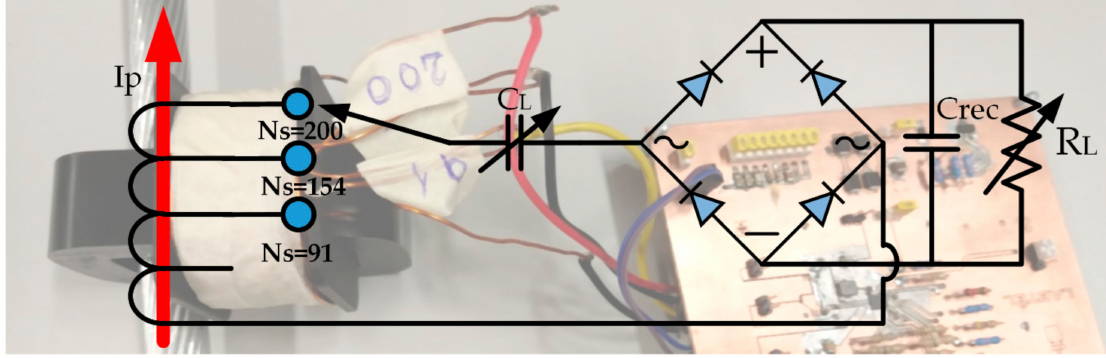
Figure 7. Circuit schematic diagram of the prototype of the harvester.